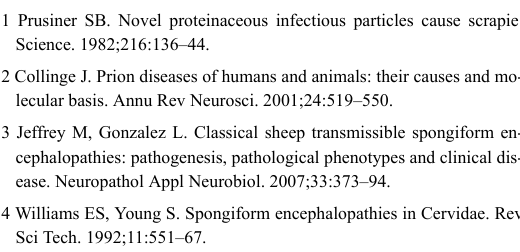
Table 1: Main features of different structural models proposed for the three dimensional structure of PrPSc. (Adapted from reference [73]).